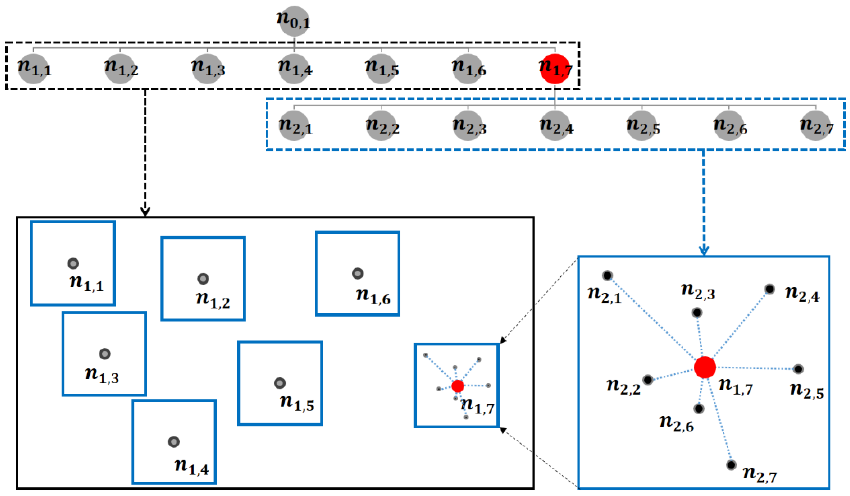
Figure 3. Spatial positioning of sub-nodes in hierarchical data.